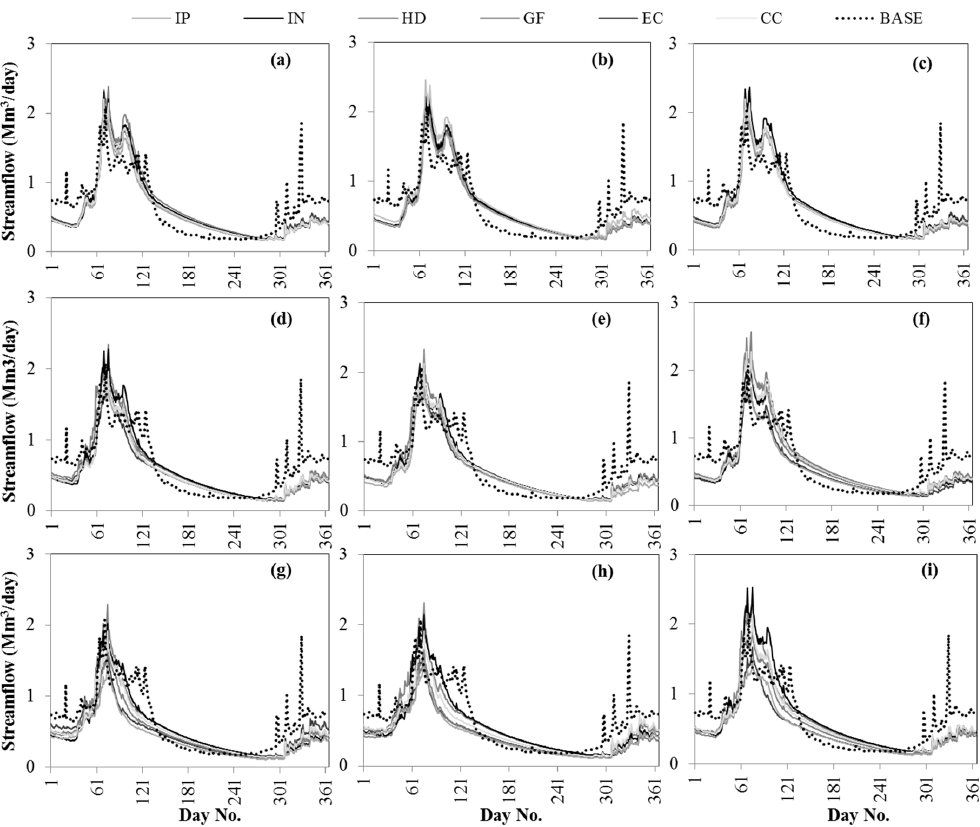
Figure 6. The annual pattern of observed streamflow (dotted graph) and future projected streamflows of SUB- 2. ( a ): A1B-2020s; ( b ): A2-2020s; ( c ): B1-2020s; ( d ): A1B-2050s; ( e ): A2-2050s; ( f ): B1-2050s; ( g ): A1B-2080s; ( h ): A2-2080s; ( i ): B1-2080s.